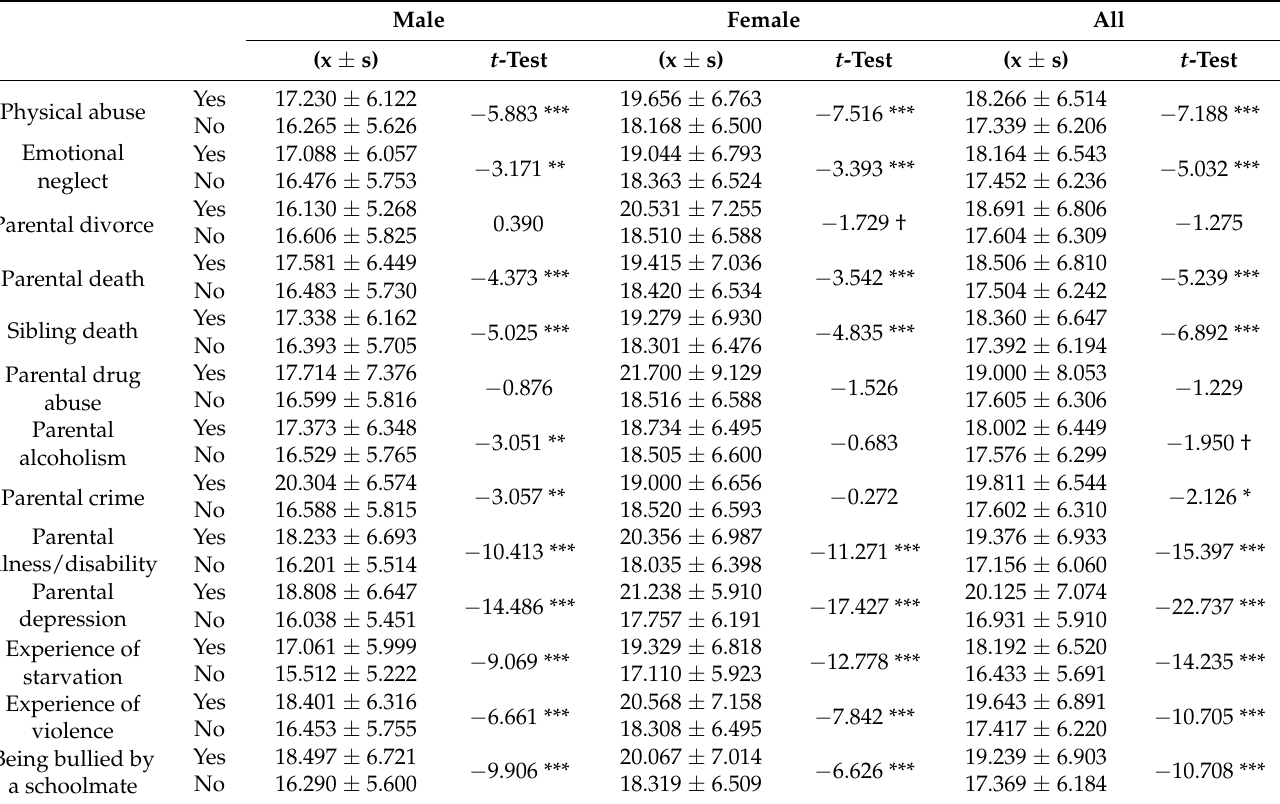
Table 3. The depression scores with different ACEs by